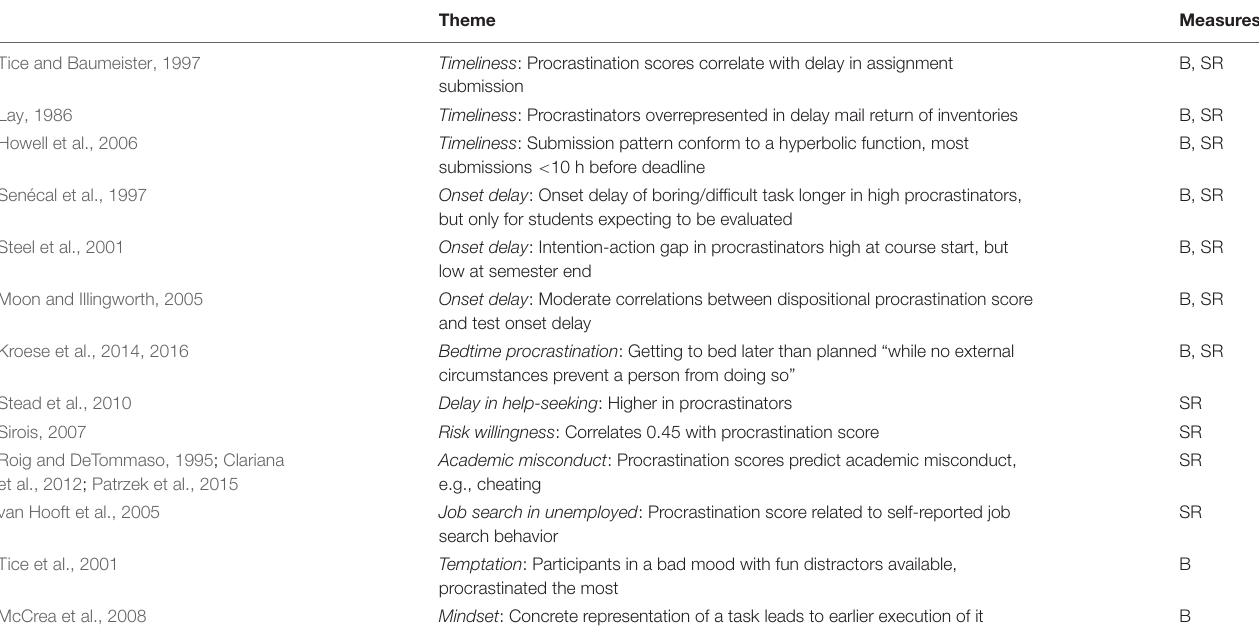
TABLE 2 | Studies assessing the self-reported procrastination–behavior relation. Theme